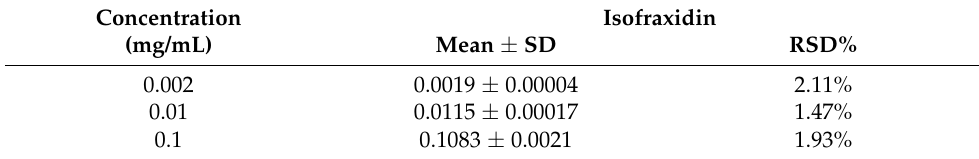
Table 1. Precision test results ( n = 6).